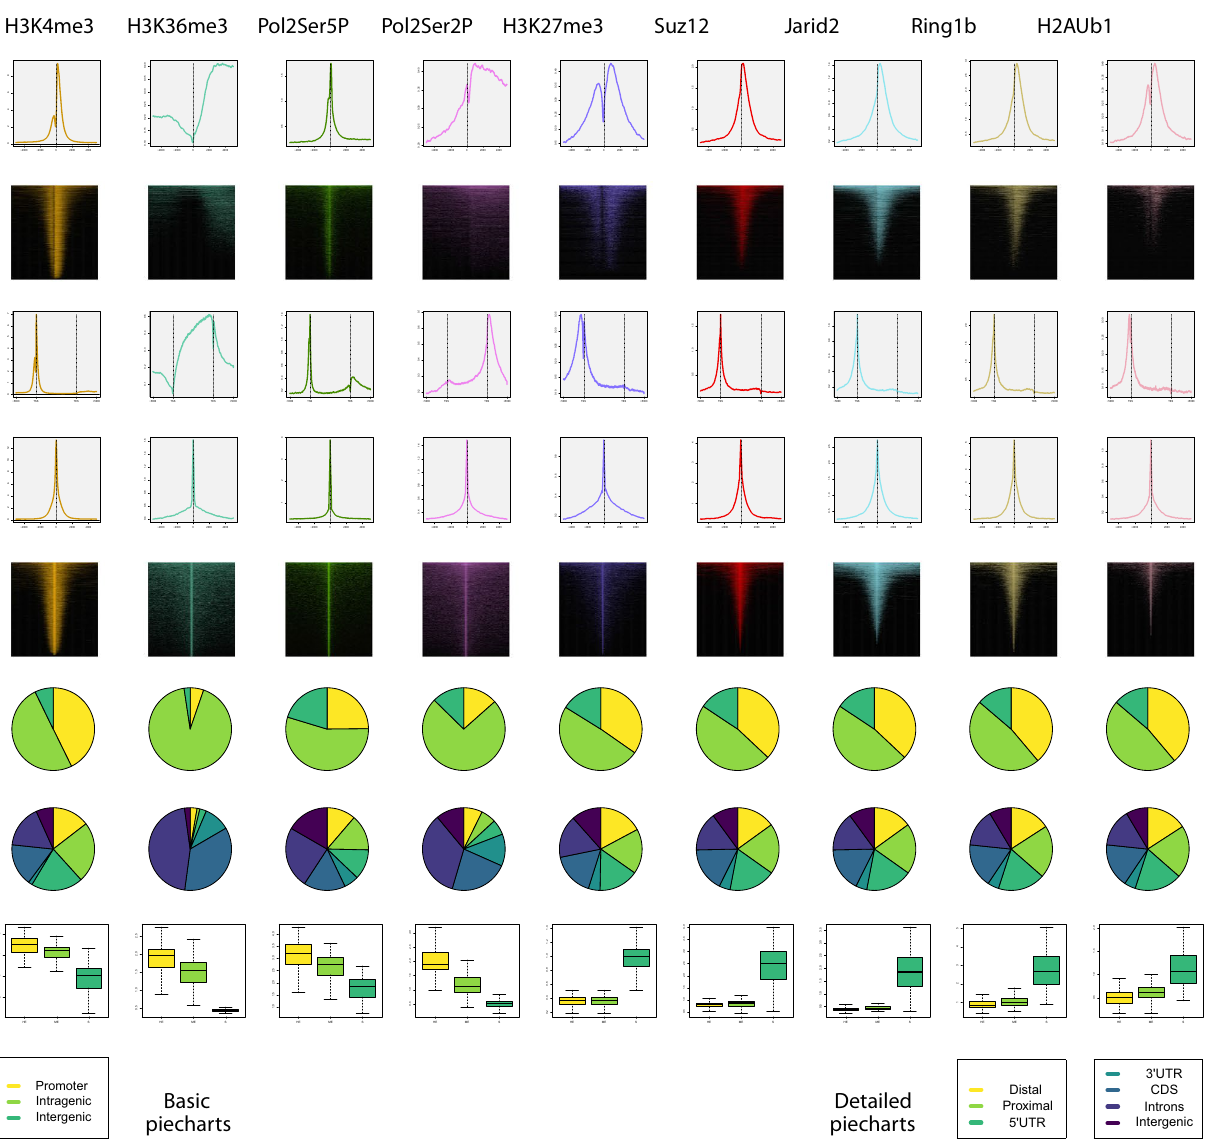
Figure 6. Panel of active and repressive actors in mESCs generated by SeqCode. For each ChIP-seq signal and corresponding set of target genes, the average distribution ( produceTSSplots ) and heatmap ( produceTSSmaps ) around the TSS, average distribution along the gene body ( produceGENEplots ), average distribution ( producePEAKplots ) and heatmap ( producePEAKmaps ) around the center of the peaks, genome distribution of each set of peaks ( genomeDistribution ), and ChIP-seq levels normalized by the total number of reads ( recoverChIPlevels ) are shown for 100 highly expressed genes (more than 1000 RPKMs; red), 100 moderately expressed genes (100–500 RPKMs; yellow) and 100 silenced genes (0–1 RPKMs; blue). Raw data were retrieved from 32,33,37,38 . Target genes of each ChIP-seq were identified with the matchpeaksgenes